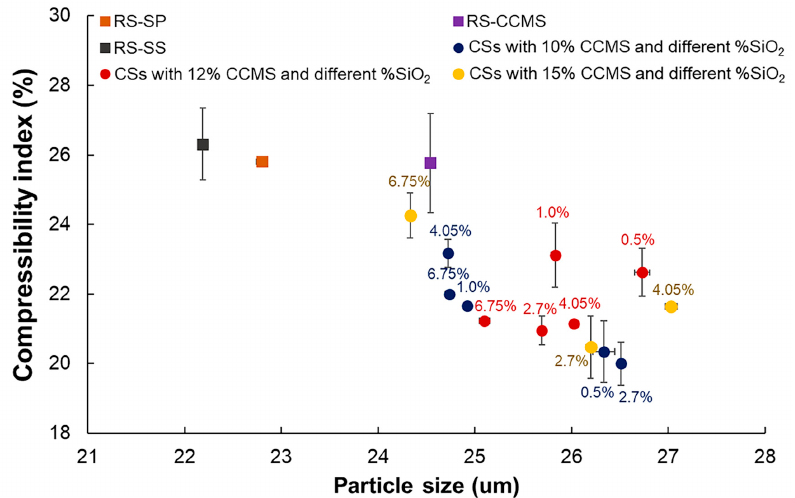
Figure 6. Relationship between the particle size of CSs with different CCMS (10%, 12%, 15%) and SiO 2 (0 . 5%, 1 . 0%, 2.7%, 4 . 05%, 6 . 75%) levels and the flowability (CI, %). (0.5%, 1.0%, 2.7%, 4.05%, 6.75%) levels and the flowability (CI,